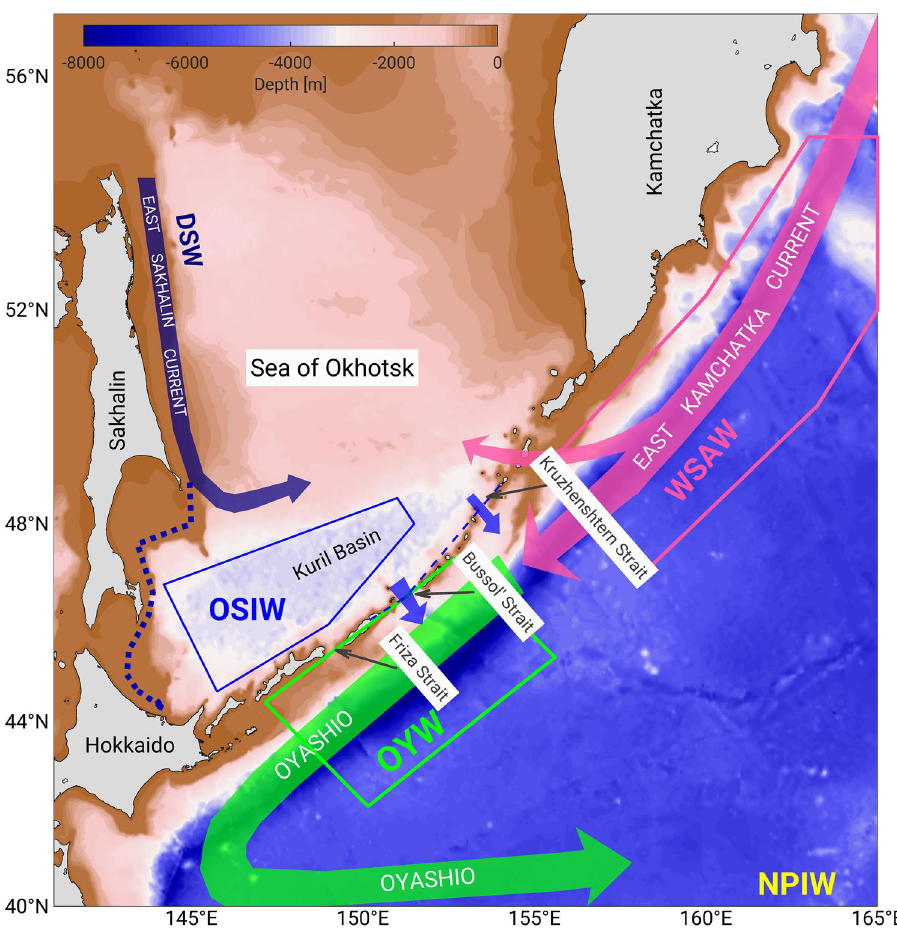
Figure 1. Schematic view of the study domain in the Sea of Okhotsk and the northwestern Pacific Ocean. The color shading represents the bathymetry. The pink, blue, and green boxes represent areas where the average properties of Western Subarctic Water, Okhotsk Sea Intermediate Water, and Oyashio Water are calculated, respectively. The dashed purple line represents a branch of the East Sakhalin Current flowing along the coast in winter. Dense shelf water (DSW) is produced on the northwestern shelf in the Sea of Okhotsk, and North Pacific Intermediate Water (NPIW) is formed partly from the Oyashio water (upper Oyashio is in the green box) and from intermediate water flowing with the Kuroshio further south (not